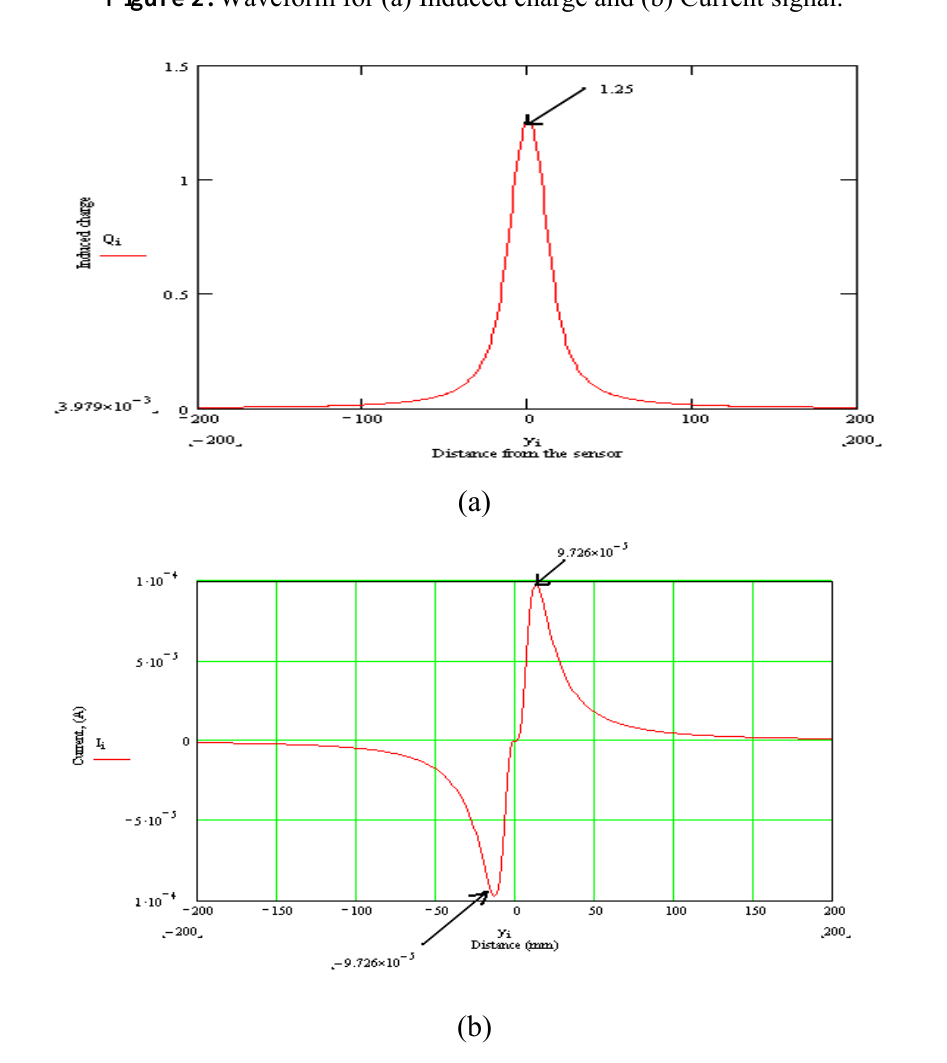
Figure 2. Waveform for (a) Induced charge and (b) Current